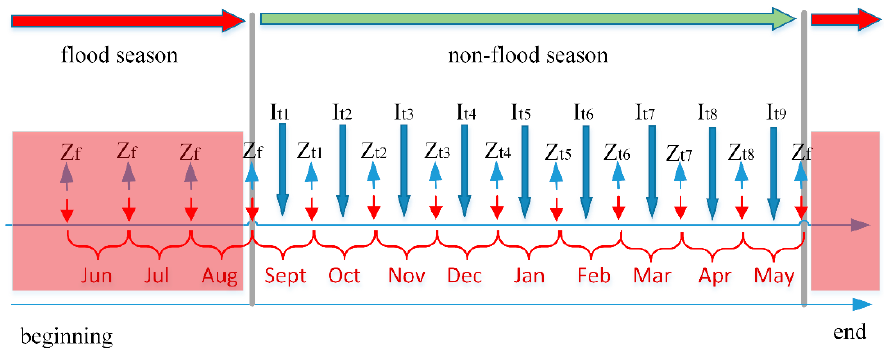
Figure 6. The schematic diagram of { Z ∗